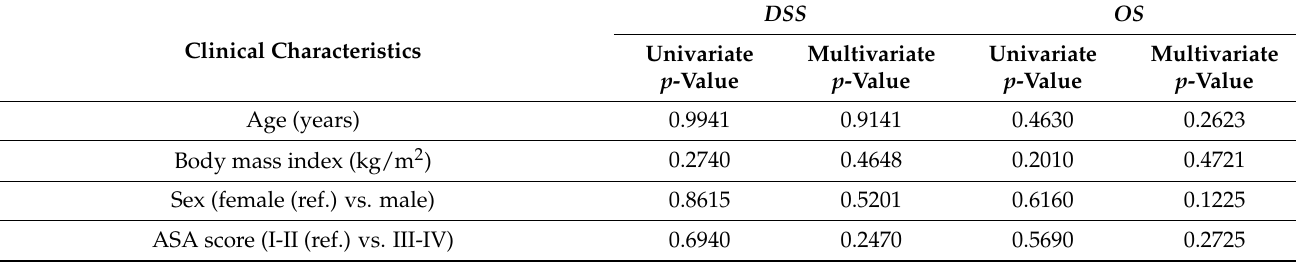
Table 4. Results of uni- and multivariate survival models of study participants with metachronous peritoneal